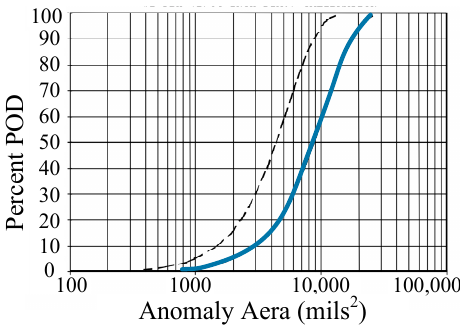
Figure 5. Probability of detection curve of ultrasonic [7].